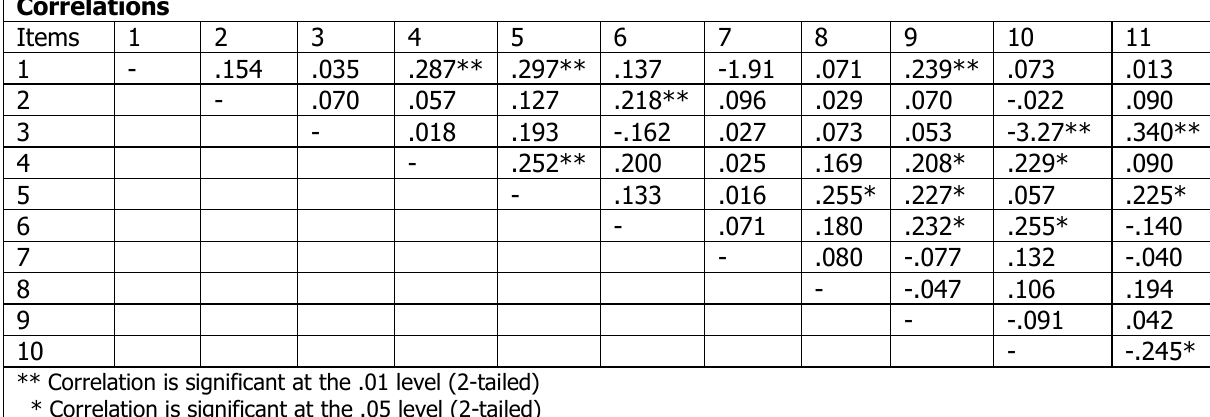
Correlation Matrix for 11-item Modified POPS Scale